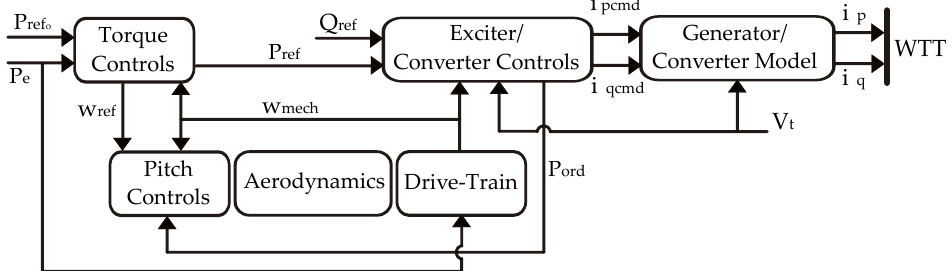
Figure 1. Control models of the generic Type 3 wind-turbine (WT) model based on Western Electricity Coordinating Council (WECC) guidelines